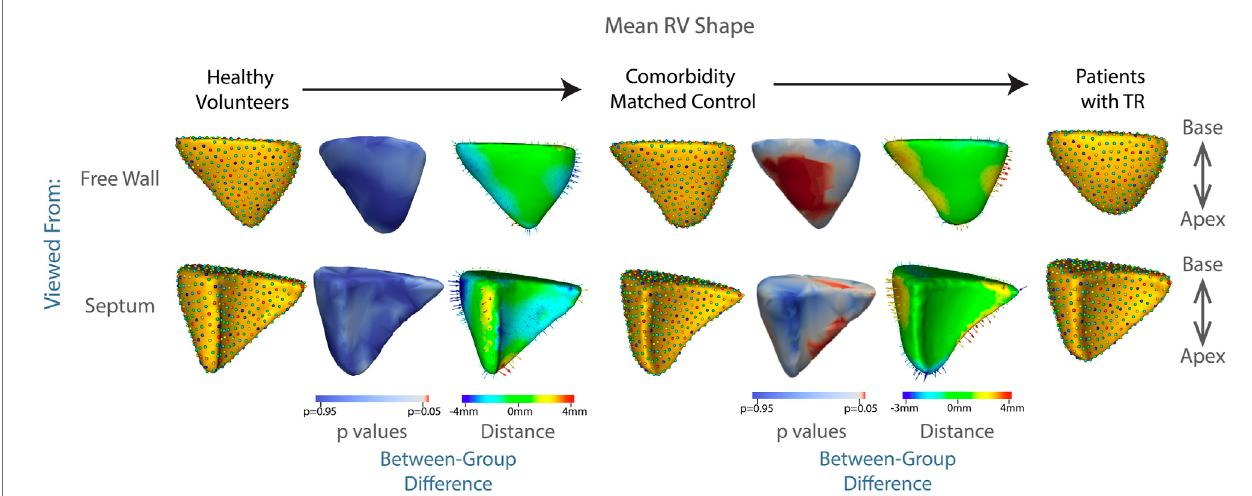
FIGURE3| Summaryofmeanshapes.Columns,1,4,and7containthemeanshapeoftherightventricleinhealthyvolunteers,patientswithcardiaccomorbidities, and patients with moderate or greater TR, respectively. Columns 3 and 6 show the difference between the group-mean shapes. The arrows indicate the direction of group differences, and the color represents the magnitude of the group difference. Columns 2 and 5 show the p -values of the group differences. The regions with red color showcase statistically signi fi cant group differences.